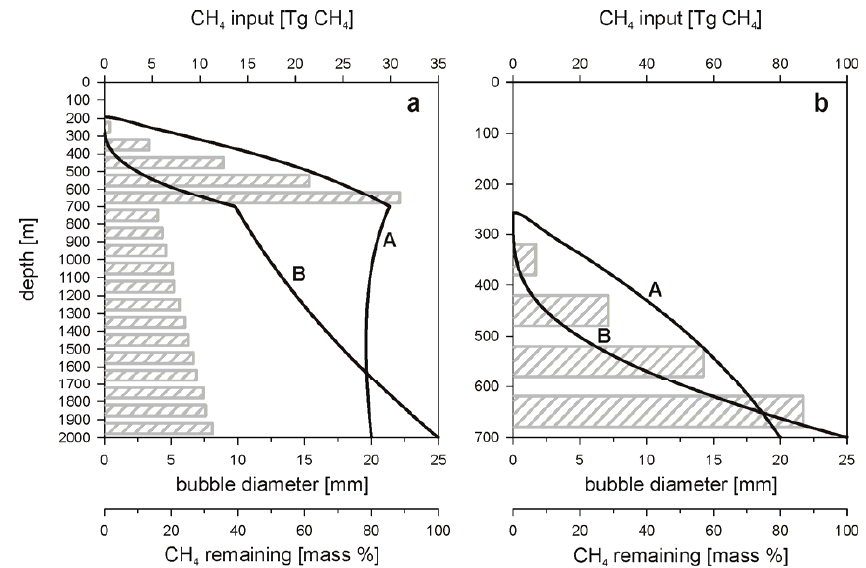
Figure 3 Fig. 3. Inputs of methane into different water depths after a release of 179Tgd − 1 of CH 4 at (a) 2000m and (b) 700m water depth. The input function is based on a bubble model predicting the (A) evolution of the bubble size and (B) the fraction of methane remaining in the uprising bubble (McGinnis et al., 2006). Note the different depth scales.